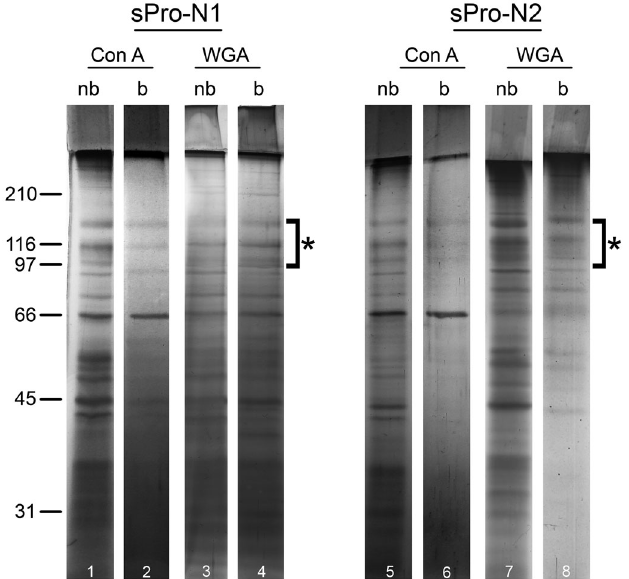
Figure 2. Protein composition of seminal prostasomes from normozoospermic men separated by lectin-affinity chromatography. Seminal prostasomes sepa- rated by lectin-affinity chromatography were resolved on 10% SDS-PAGE under reducing and denaturing conditions and stained with silver. Representative total protein patterns of non-bound (nb) and bound (b) fractions separated on a Con A column and on a WGA column were shown. Samples were loaded as isolated (equal volume/line to reflect yield), and total protein amounts were: line 1 (32 l g), line 2 (9 l g), line 3 (17 l g), line 4 (11 l g), line 5 (18 l g), line 6 (5 l g), line 7 (14 l g), line 8 (12 l g). Characteristic prostasome-associated bands in the region of 90 – 150kDa are marked (asterisk). Numbers indicate the pos-